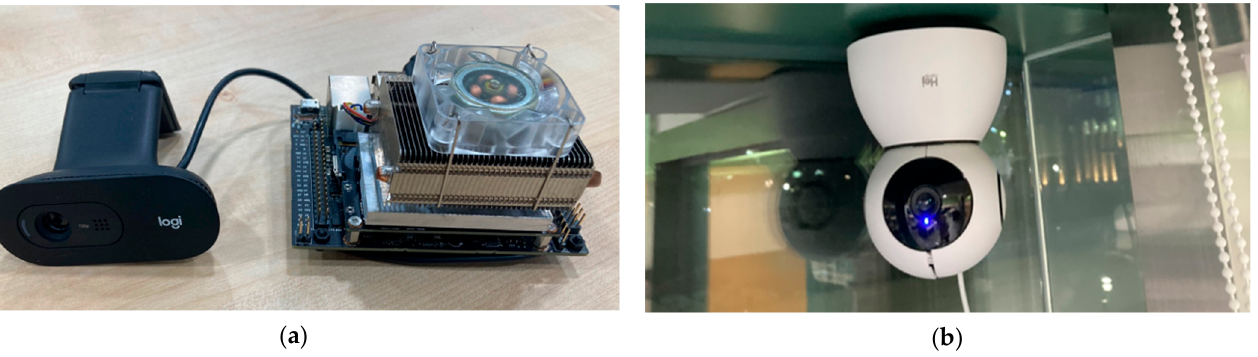
Figure 4. Camera for collecting occupancy data: ( a ) camera for sensing data collection (type-1); ( b ) camera for ground-truth data collection (type-2).